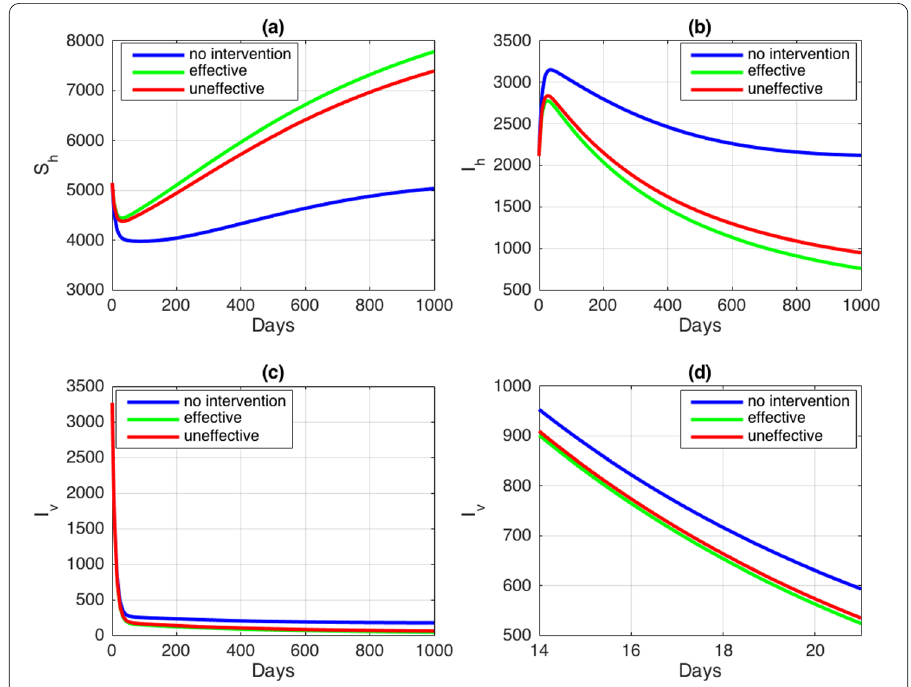
Figure 5 Autonomous simulations with changes in parameter k . The blue curve represents no intervention, the red curve indicates that the bed nets are not effective, and the green curve indicates that the bed nets are